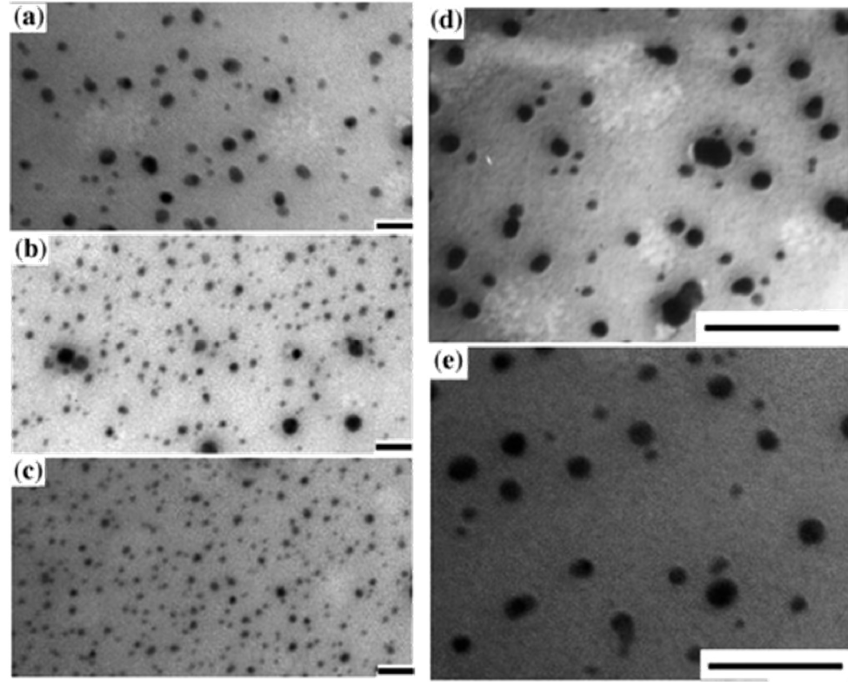
Figure 3. TEM micrograph of size-tunable PVP-coated spherical PBnp from Reference